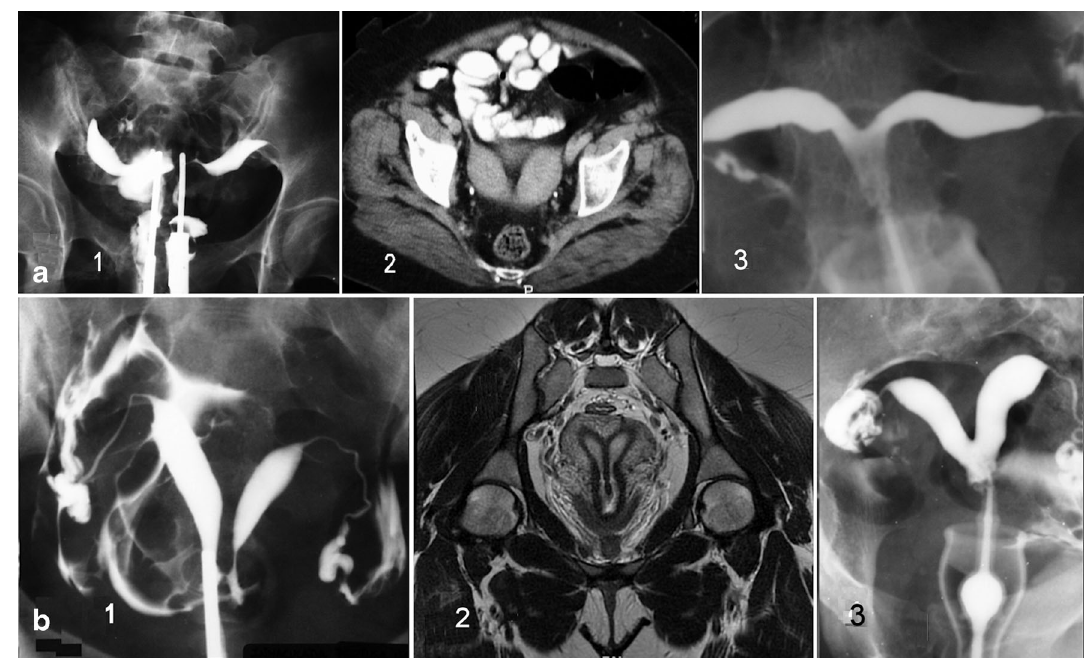
Fig. 6 Didelphys, bicornuate and septate uteri. a 1. HSG image of a patient with didelphys uterus obtained using a double simultaneous cannula. 2. CT of other patient showing a bicornuate uterus. 3. HSG image of a bicornis-unicollis uterus. b 1 HSG showing a complete septate uterus and communicating septate uterus. HSG was obtained